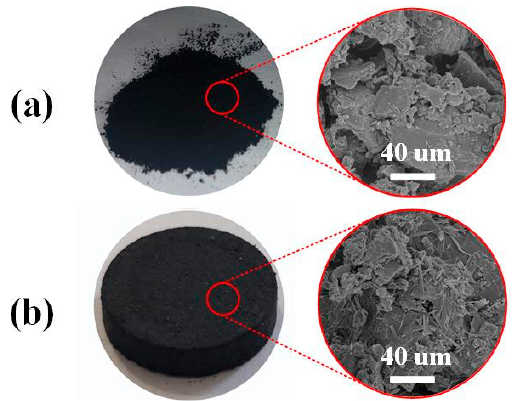
Figure 6. SEM of resultant materials in various stages ( a ) R-AC and ( b ) AC-Si-0.2-0.3.